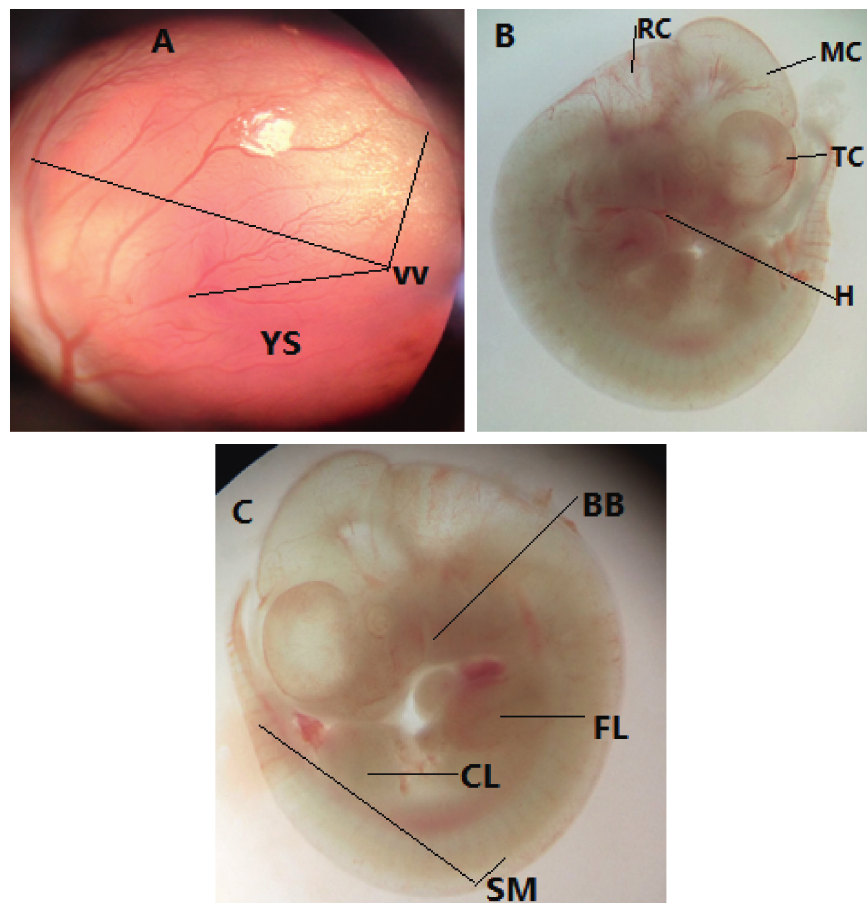
Figure 2: A 12-day-old rat embryos showing various organs of primordia. (a) An embryo enclosed inside the intact yolk sac (YS) with vitelline vasculature surrounding it (VV); (b) yolk sac-free embryo, separated from the surrounding blood vessels, revealing the heart (H), telencephalon (TC), mesencephalon (MS), and rhombencephalon (RC); and (c) brachial bars (BB), forelimb bud (FL), somites (SM), and caudal limb bud